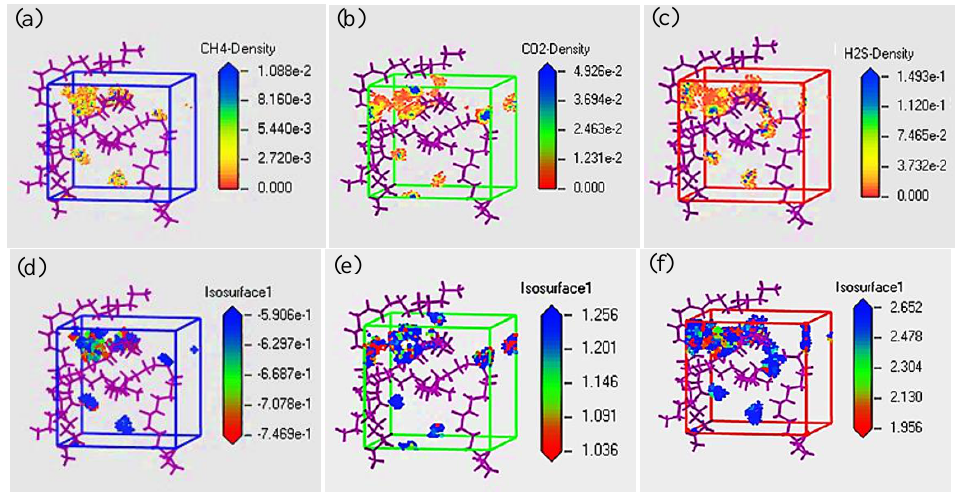
Figure 6. Density field distribution and isopycnic of CH 4 molecule ( a , d ); CO 2 molecule ( b , e ); H 2 S molecule ( c , f ) in simulated cell at 2.5 MPa and 30 ◦